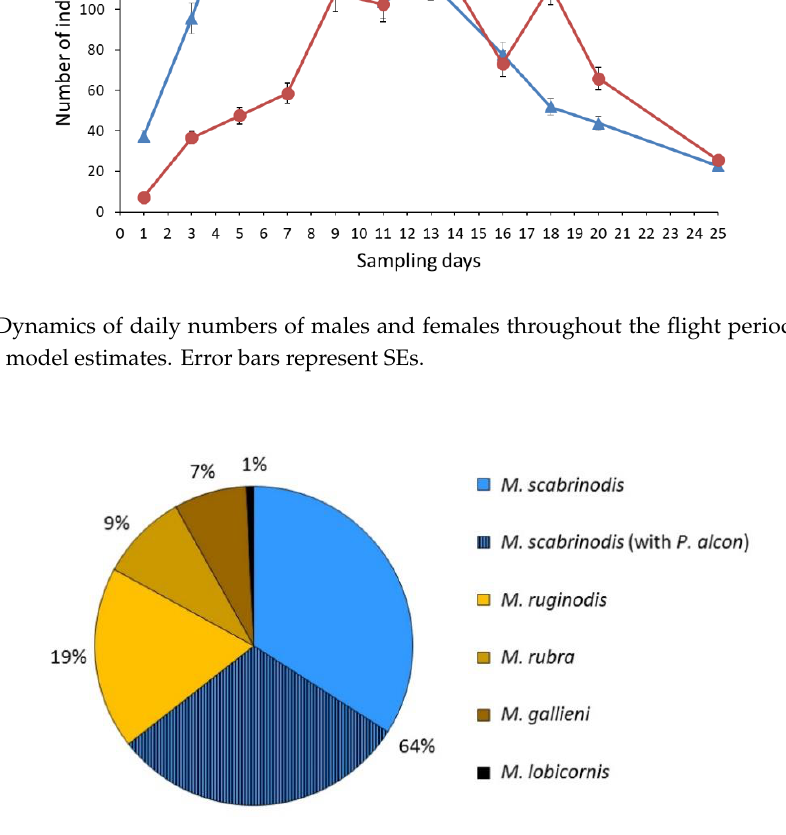
Figure 6. Parasitized (marked with arrows) and unparasitized pupae of Phengaris alcon in a nest of Myrmica scabrinodis. Figure 7. A female Ichneumon cf. eumerus reared from a pupa of Phengaris alcon.